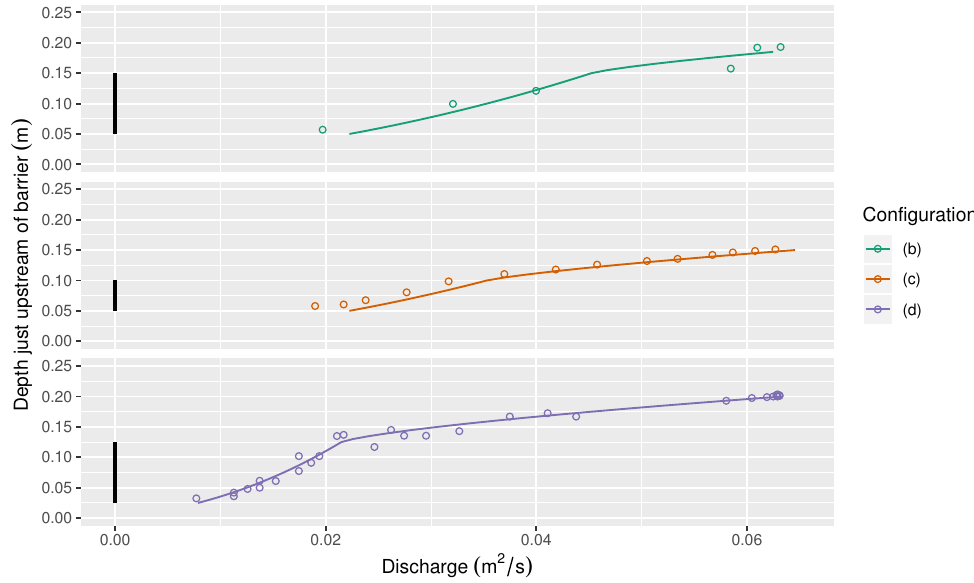
Figure 4. Measured depth-discharge relationship (circles) and the empirical discharge equation with C c = 0.70 and C w = 0.70 (lines) for each barrier configuration. Only includes free-flow scenarios where the depth is greater than the gap underneath the